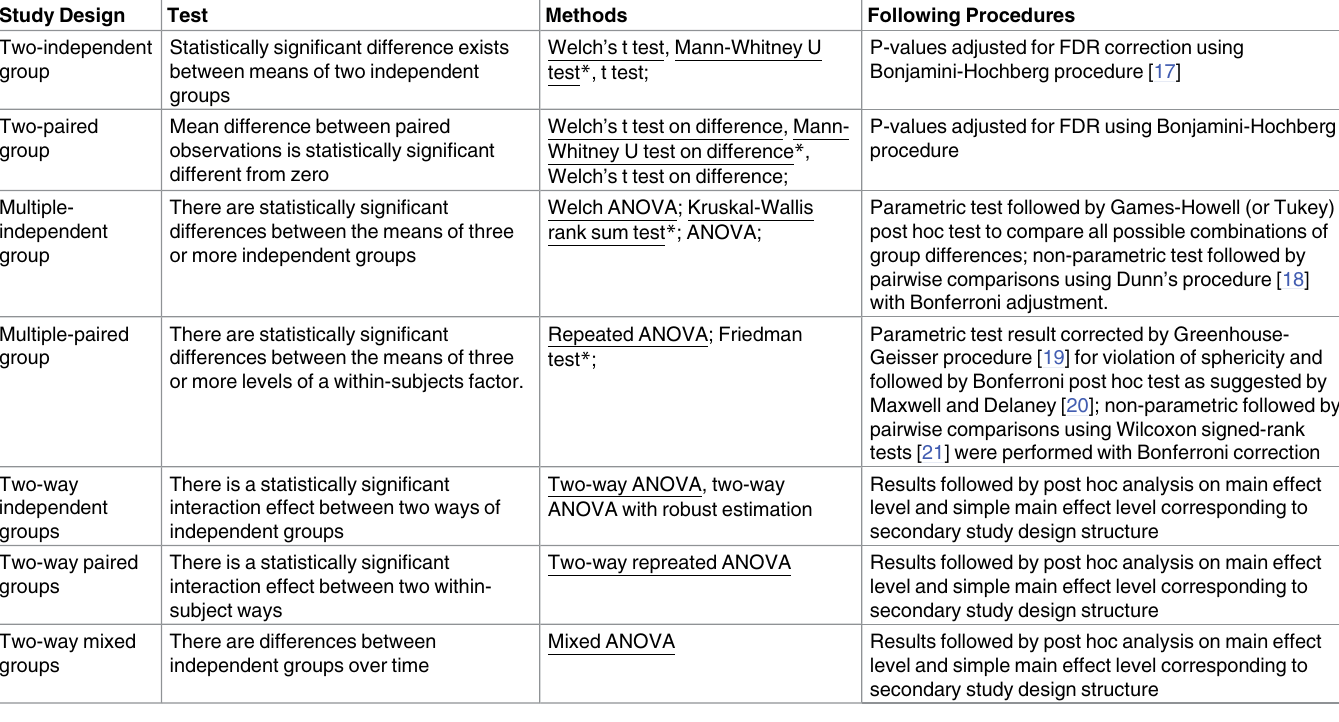
Table 1. List of statistical analysis procedures in